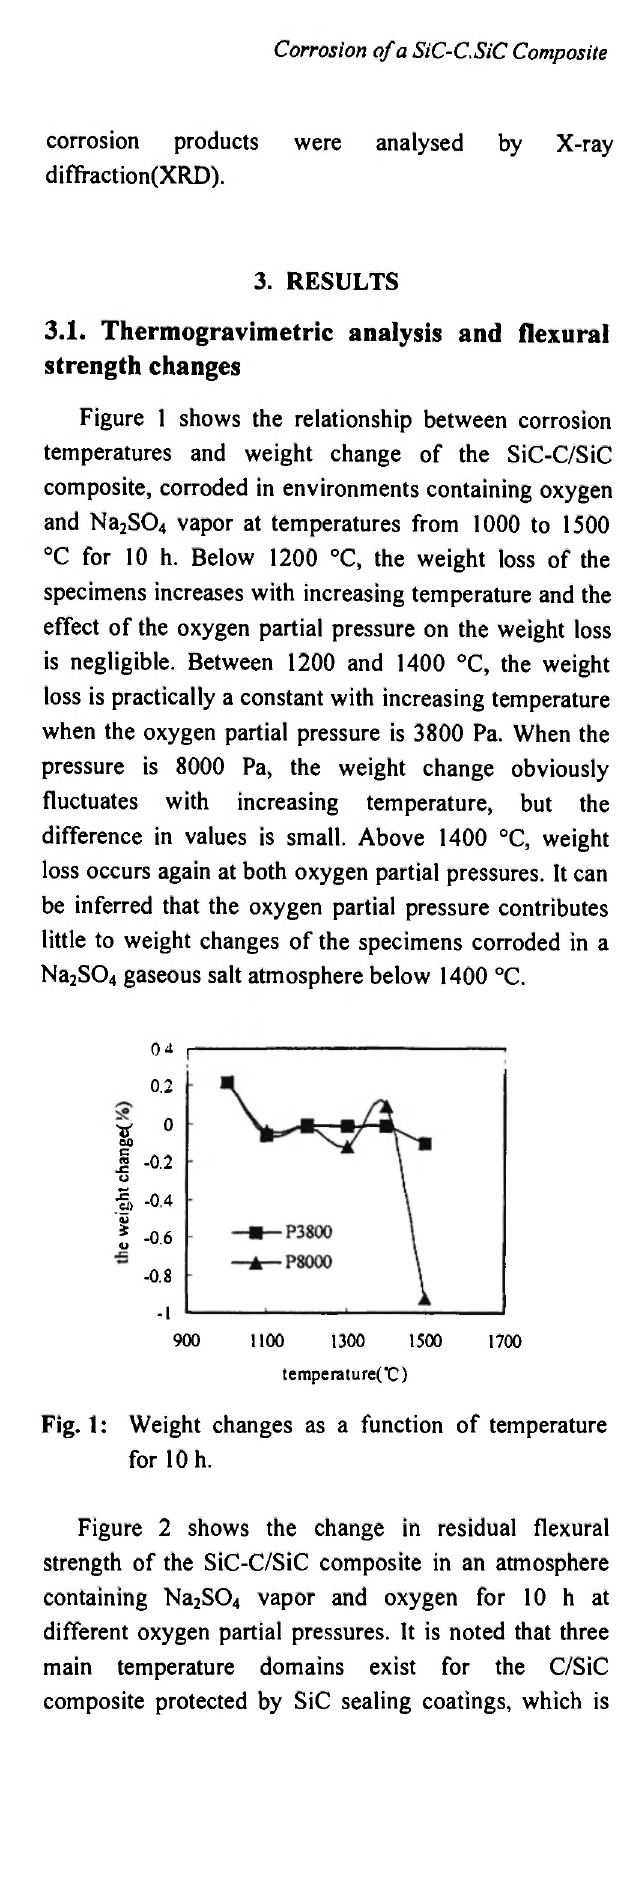
Fig. 1 : Weight changes as a function of temperature for 10